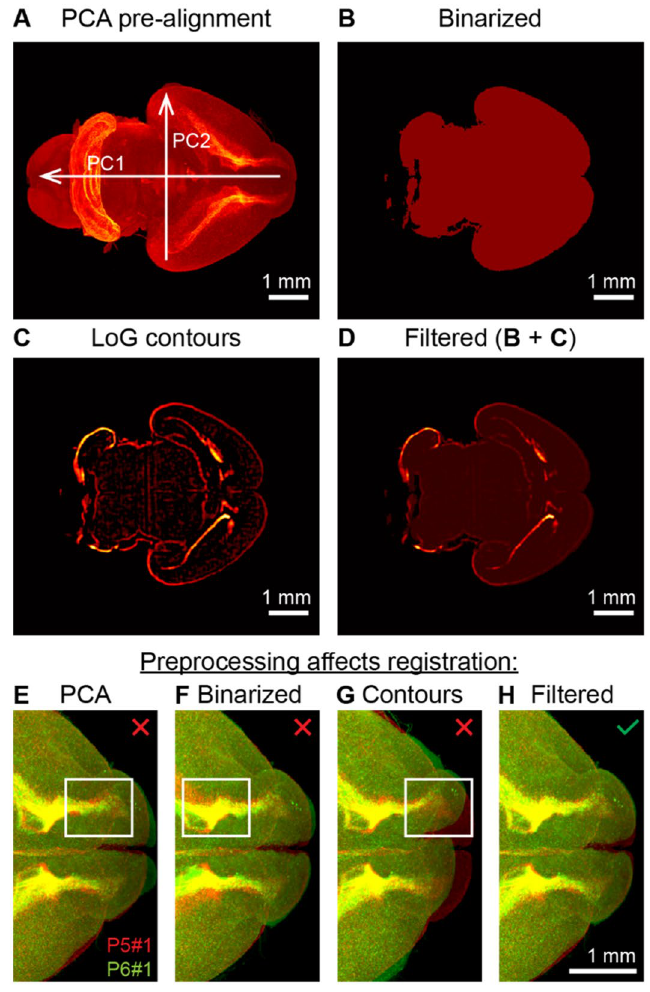
Figure 2. 3D image preprocessing steps improving brain registration. ( A ) Brain sample pre-alignment via rotation and scaling using Principal Component Analysis (PCA). ( B ) Cross-section of the binary mask of the brain sample. ( C ) Contours of the brain regions extracted with Laplacian of Gaussian (LoG) filter. ( D ) Filtered image; a weighted sum of ( B ) and ( C ). ( E – H ) Registration of two brains taken at P5 and P6 using individual image preprocessing methods as indicated. Registration of raw images ( E ) results in slight mismatches between Rostral Migratory Streams (RMSs). Registration of binary masks ( F ) results in a mismatch of the inner structure. Registration of brain region contours ( G ) may not converge and results in large mismatches between samples. The combination of binary mask and contours ( H ) solves the problems of ( E – G ) yielding a higher quality